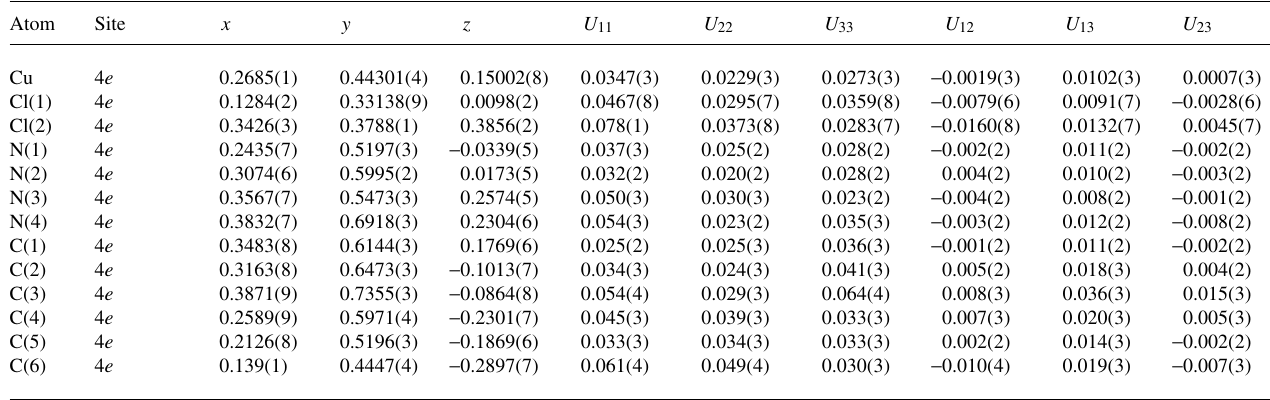
Table 3. Atomic coordinates and displacement parameters (in Å 2 ) .